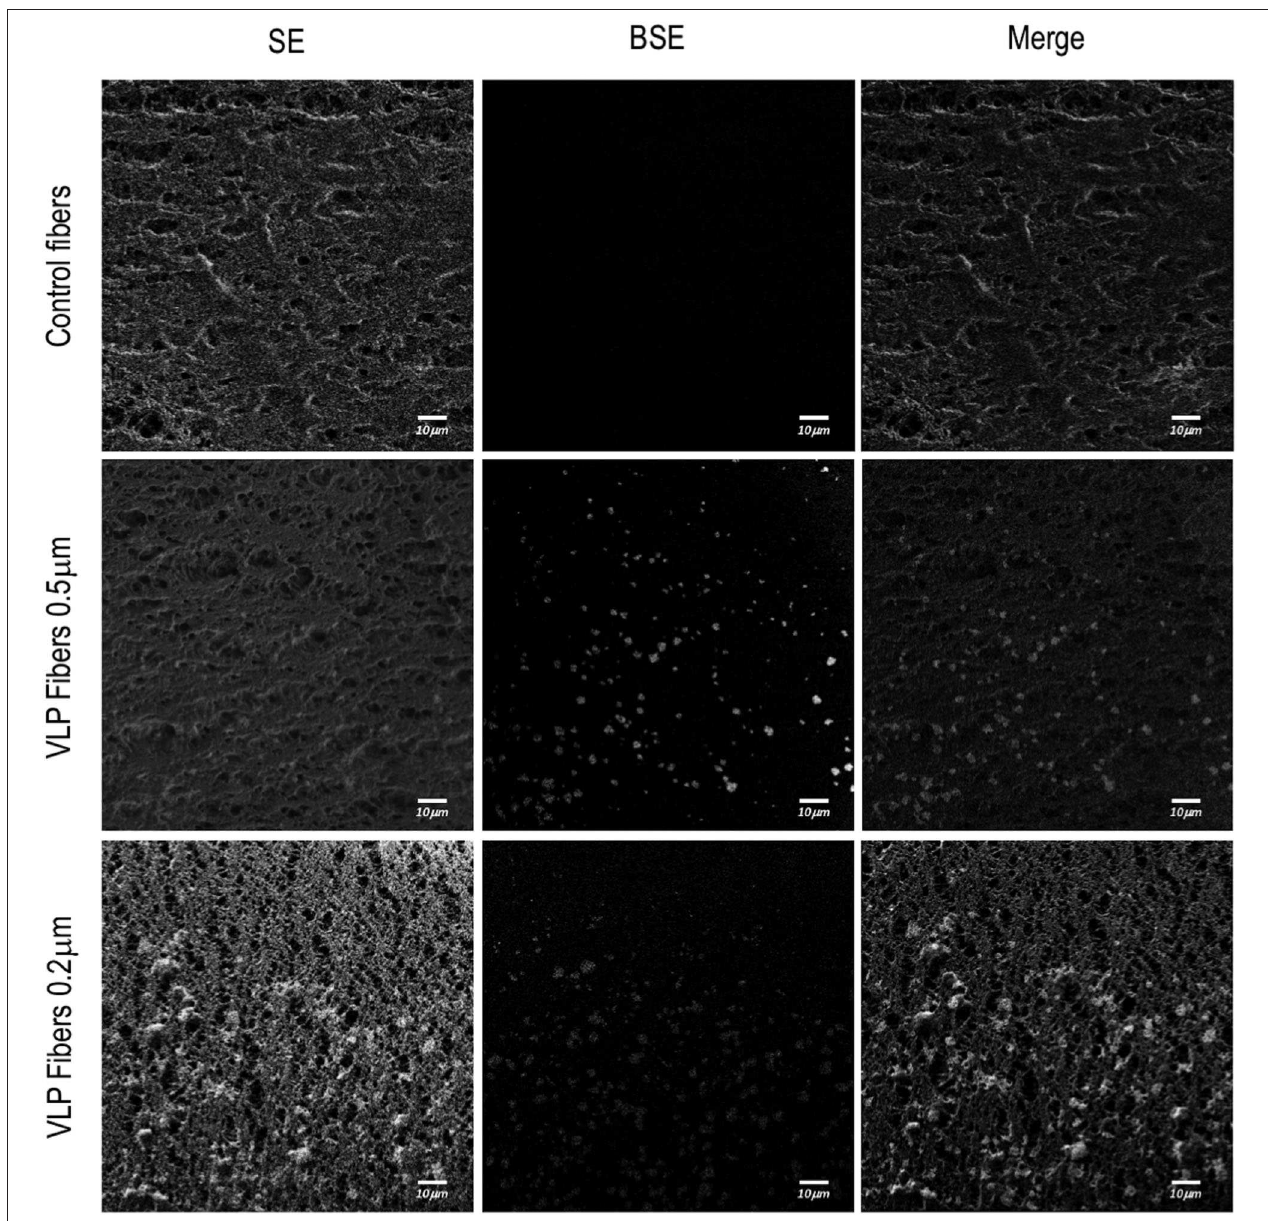
FIGURE 5 | Visualization of a ATF hollow fiber inner side from a longitudinal cut using field emission scanning electron microscopy (FESEM). Rows represent the different studied conditions: control fibers used in non-producing-VLPs HEK293 cultures and fibers used in VLP-producing HEK293 cultures of 0.5 and 0.2 µ m of pore diameter. Images were taken at 3.4mm of working distance and 129,000x. The first column shows the morphology of the fibers using scanning of secondary electron (SE) detection. The second column shows back-scattered electron (BSE) detection for fluorescence detection from the same area. The third column shows the merge of the SEM image and the electron back scattering